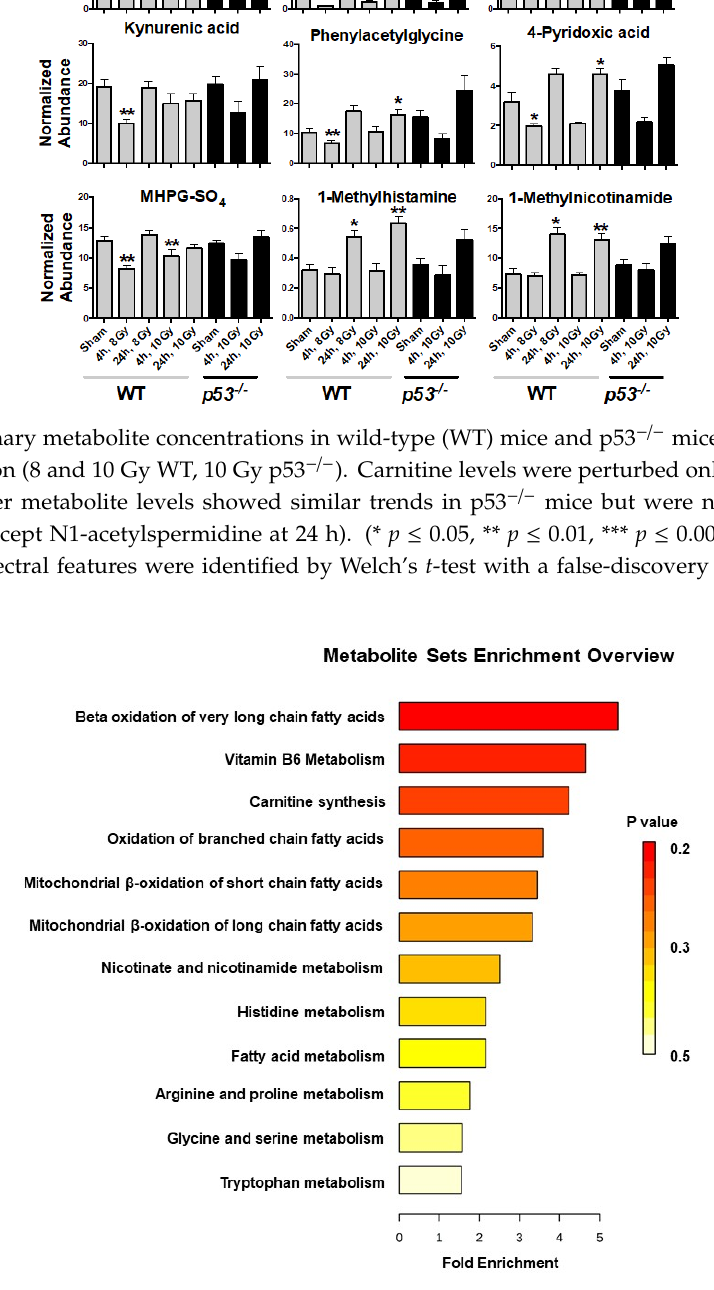
Figure 3. Hierarchical representation of impacted metabolic pathways identified in wild-type and p53 − / − mice post-irradiation. Metabolic pathways were identified in MetaboAnalyst using the Kyoto Encyclopedia of Genes and Genomes (KEGG) database, The Small Molecule Pathway Database, and Human Metabolome Database